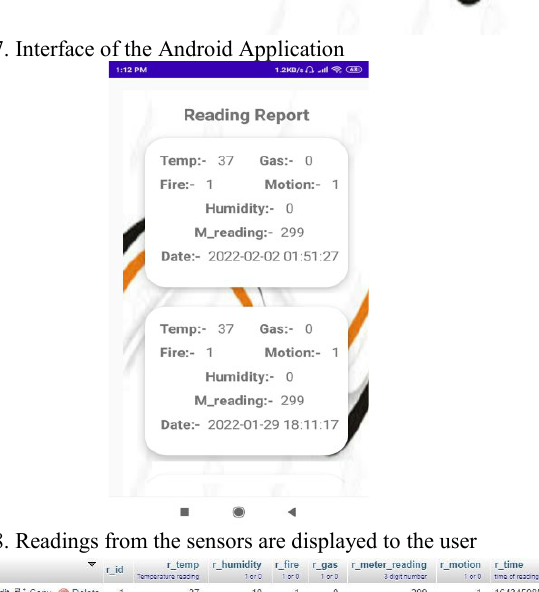
Fig. 7. Interface of the Android Application